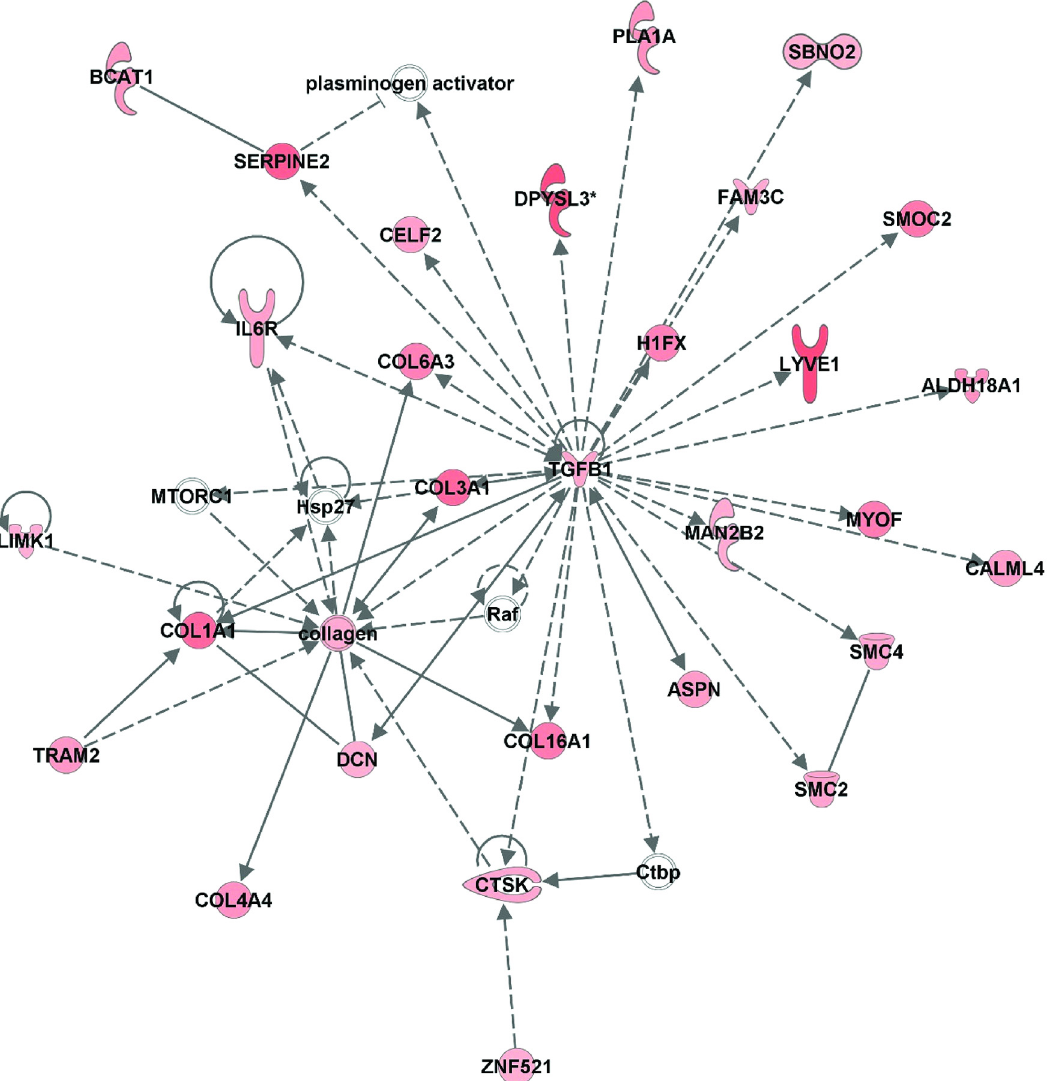
Fig 4. Top scoring network inclusive of up-regulated genes (score = 47) in LOCK vs RUN. Nodes represent genes/molecules. Shading is proportional to fold change size (red: up-regulated). Direct and indirect relationships are denoted with solid and dashed lines, respectively. White nodes denote network members that were not altered in the network. Lines ending in an arrow or blunt end indicate known direction of molecular activation or inhibition, respectively. Different shapes of genes represent different gene